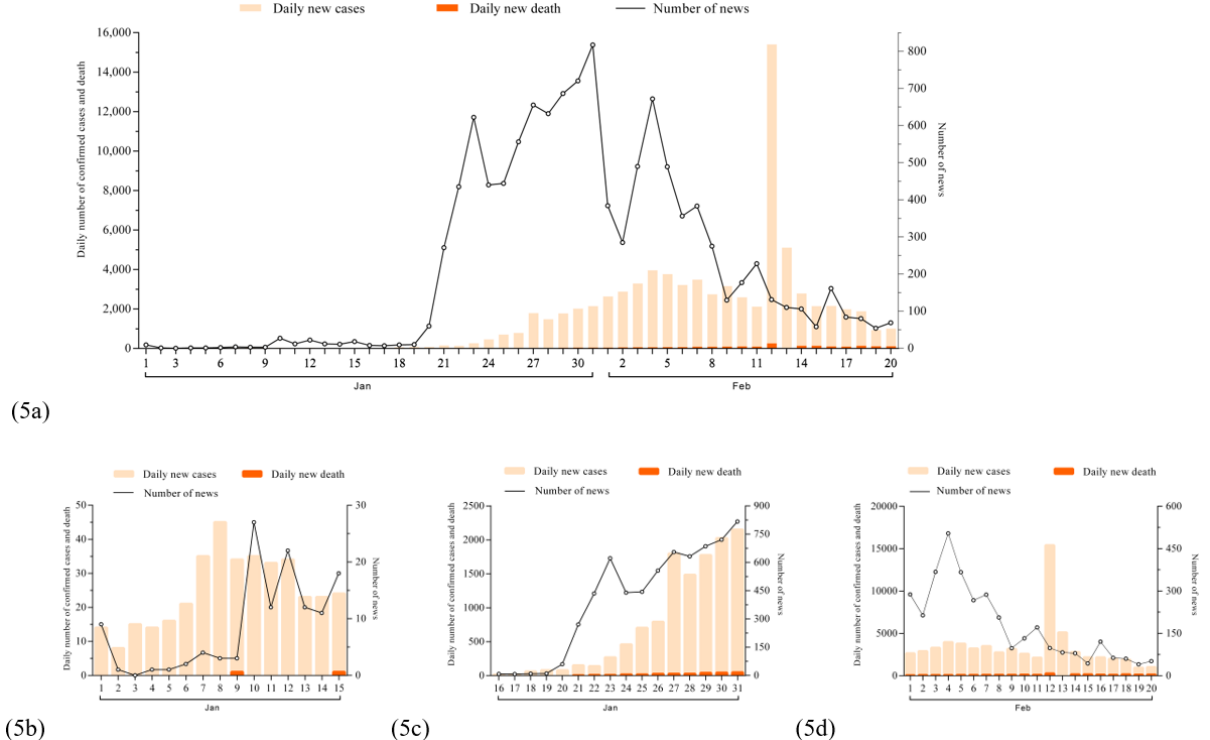
Figure 5. Timeseries of news streams with daily confirmed cases and deaths.